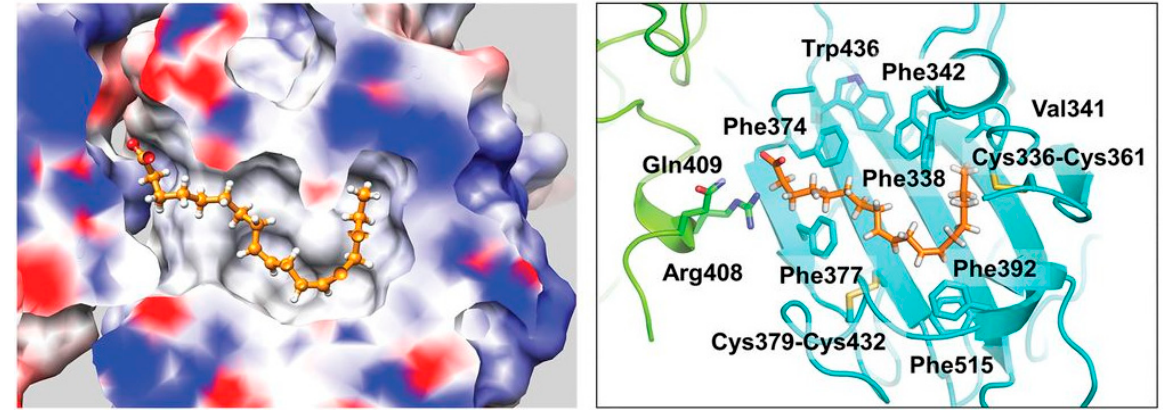
Figure 1. FABP with linoleic acid bound ( left ) and residues lining the pocket ( right ). CC BY 4.0 licence from Toelzer et al. [3].